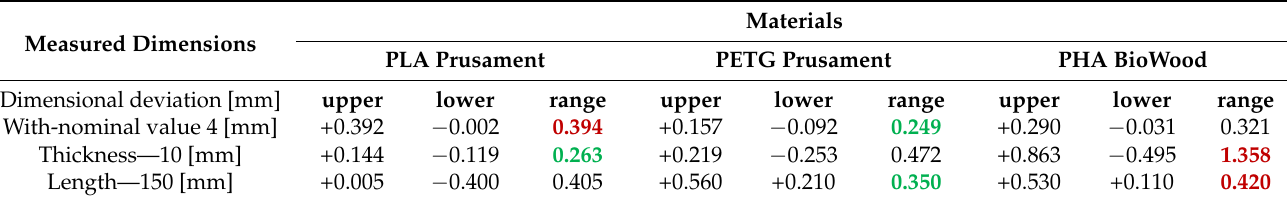
Table 4. Deviations from nominal dimensions of the